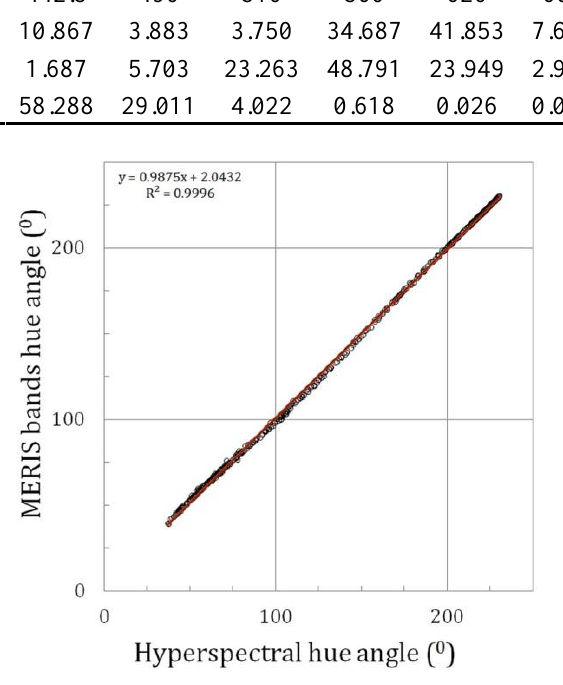
Figure 4. The true hue angle as function of the linear hue angle derived from the MERIS band